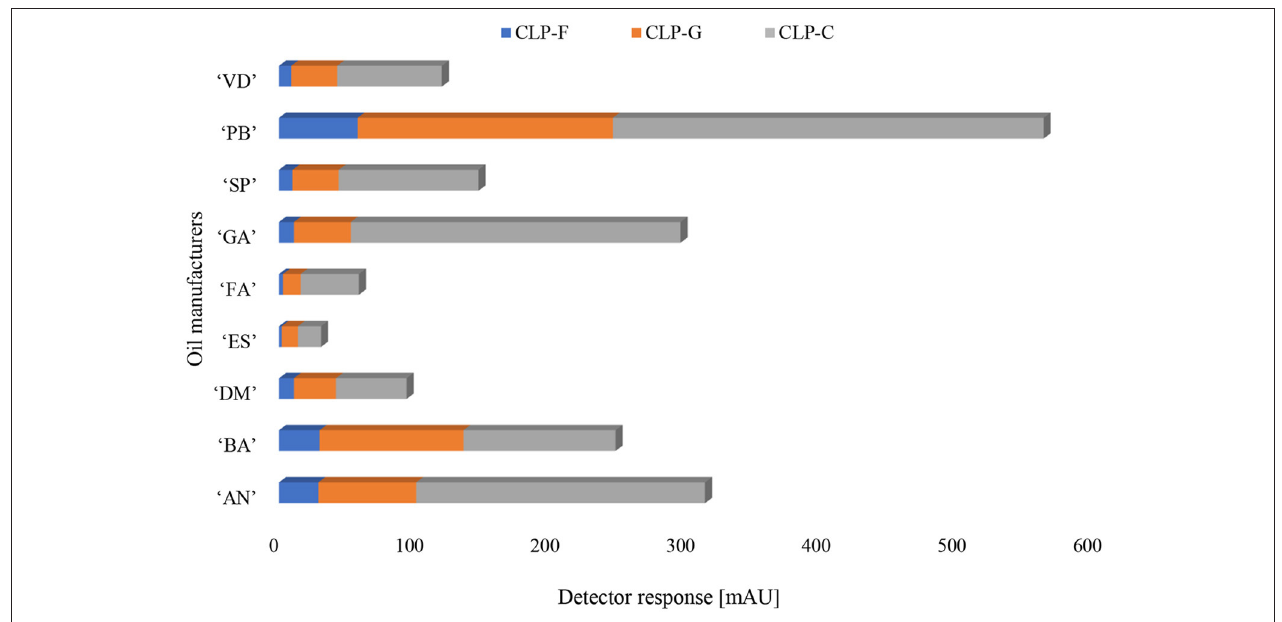
FIGURE 3 | Comparison of CLP-C, CLP-F, and CLP-G, which occur in all